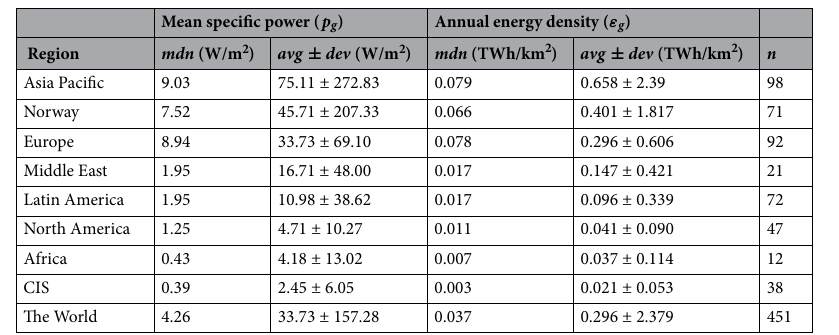
Table 8. Mean and annual power and energy densities for hydropower in the different